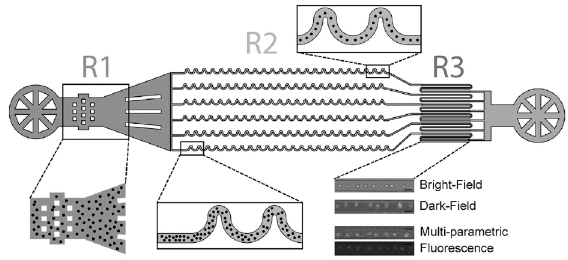
Fig. 1. Schematic of an inertial microfluidic flow cytometer highlighting the inlet port (blue), inertial focusing channels (orange), imaging area for the detection (green), and the outlet port for the collection (gray). (R1) Filter for removing the cell debris, cell aggregates, and the clumps. (R2) Schematic of the cells flowing at the beginning and at the end of the inertial focusing channel. (R3) Representative images from all the possible imaging modalities of the detection. All scale bars represent 30 mm. Image adapted and reproduced from